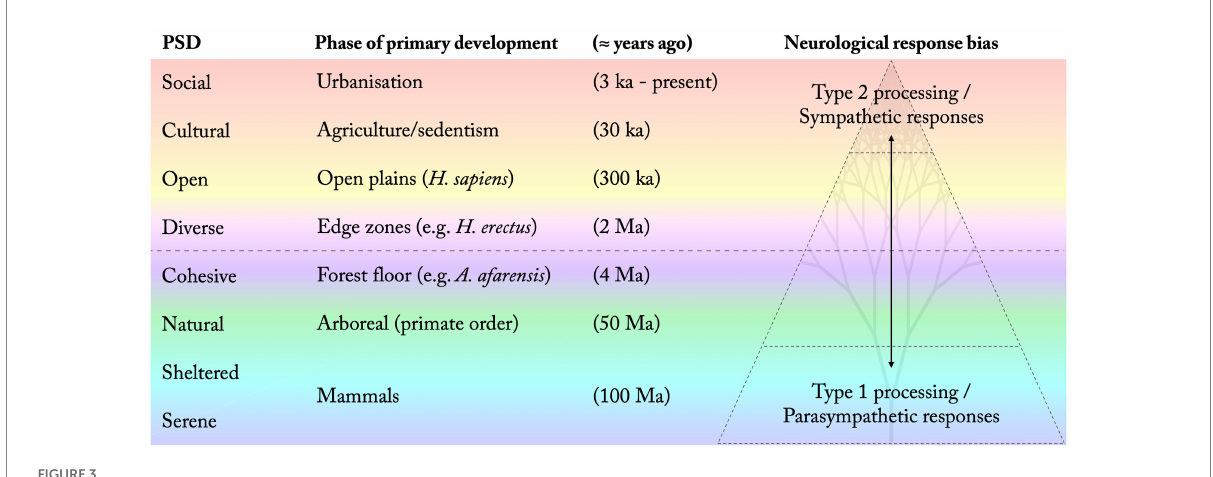
FIGURE 3 Suggested order (bottom to top) and phase associated with the development of each perceived sensory dimension (PSD). The increased complexity of our environmental relations over time is reflected in a shifted bias towards Type 2 cognition and sympathetic responses. (Time indications are estimates based on suggestions in the